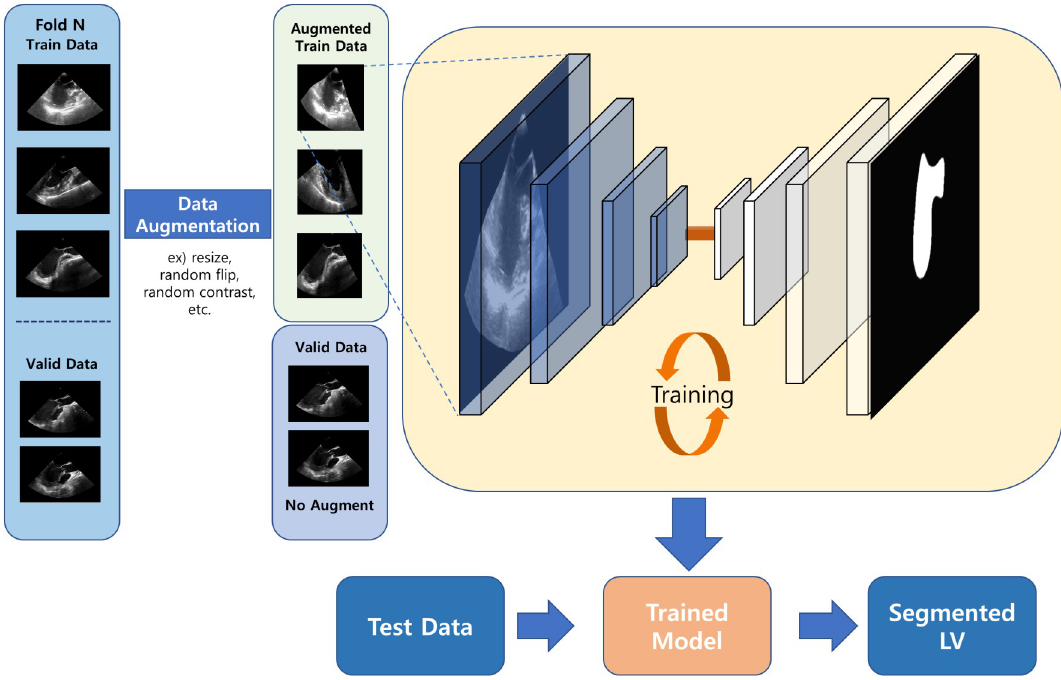
Fig 1. Workflow of LV segmentation in TEE images. The dataset was split into train, validation and test dataset. The training dataset was increased by the augmentation method, because of the limited data. LV, left ventricle; TEE, transesophageal